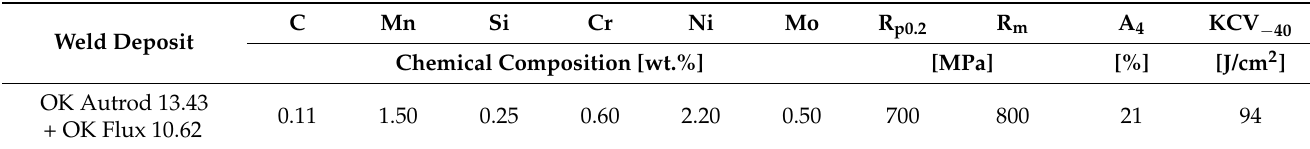
Table 4. Properties of the weld deposit used to complete a welded joint of Hardox 450 steel [27]. R p0.2 —proof strength, A 4 —percentage elongation after fracture, KCV -40 —impact toughness at − 0